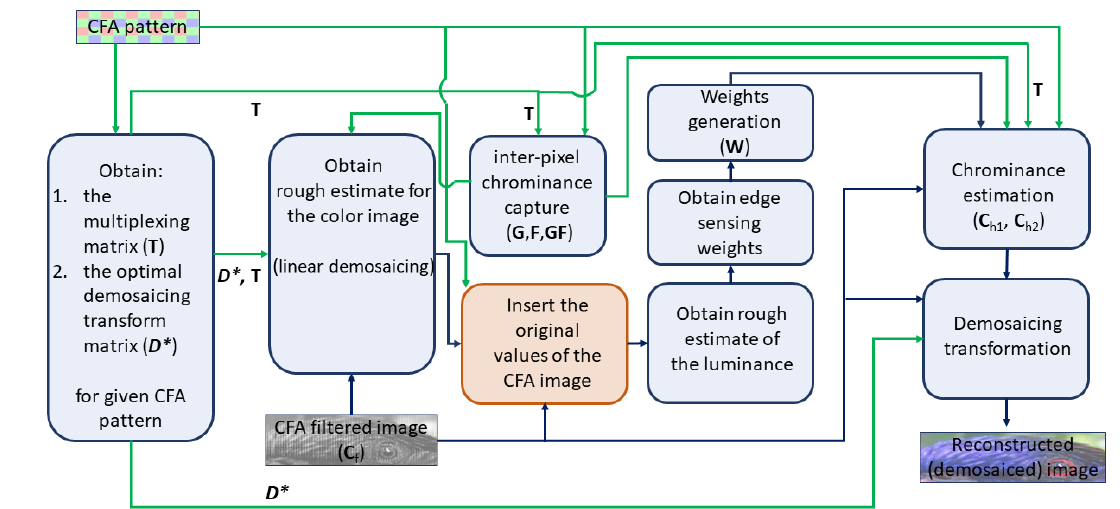
Figure 2. Flowchart of ACUDe and our modifications. Modifications are represented with the procedure in the orange block. Green arrows represent the data-flow between procedures (given with blocks) where only the color filter array (CFA)pattern is used. Blue arrows represent the data-flow between procedures (given with blocks) where also a CFA input image is used.